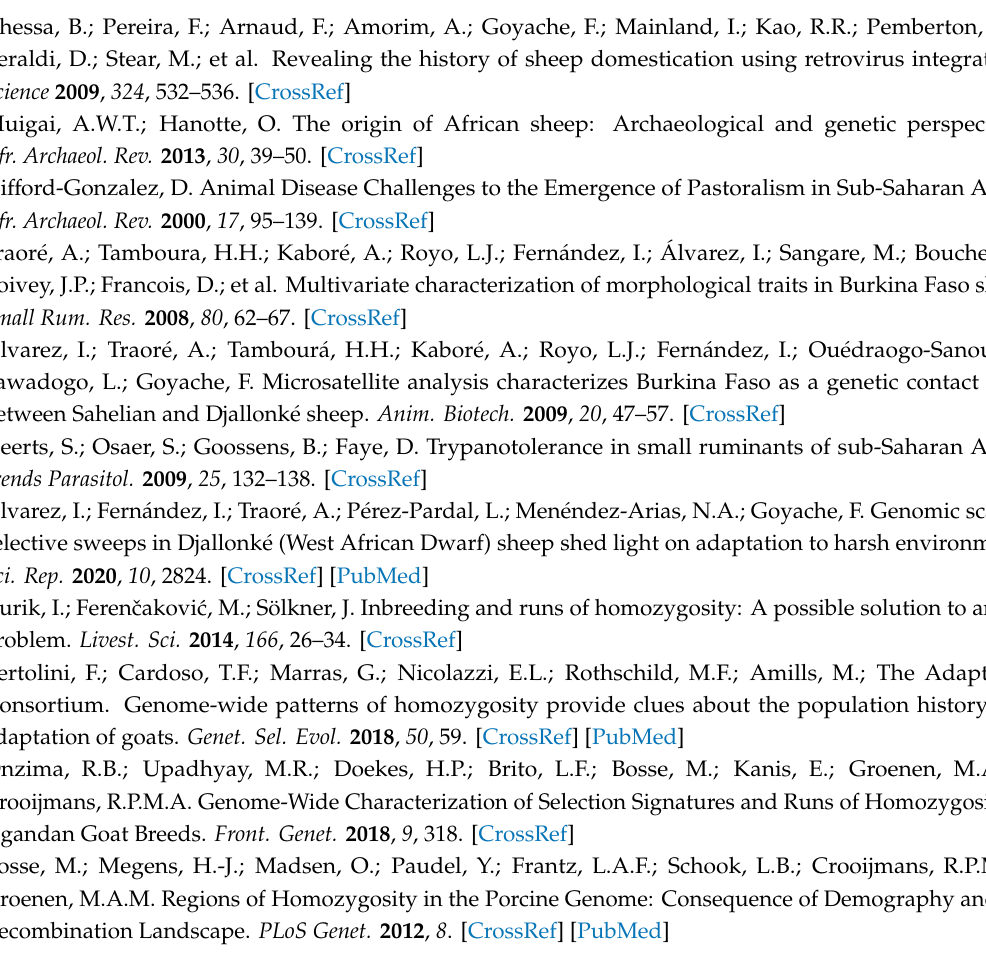
identified using the program ZooROH, Table S3: List of candidate genomic regions identified, Table S4: Functional terms enriched clusters identified using candidate genomic regions, Table S5: List of candidate genes located on the 75 kb up- or down-stream of the ROH identified, Table S6: List of candidate regions overlapping with selection sweeps previously reported [7] on the same Djallonk é